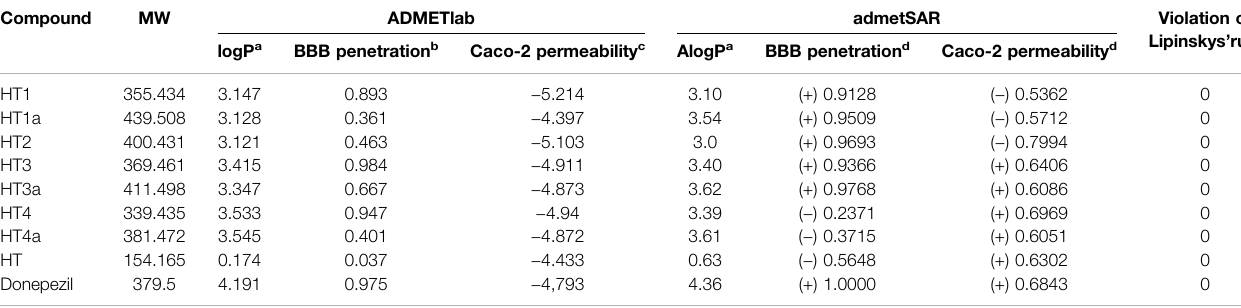
TABLE 4 | Pharmacokinetic properties as predicted in silico by software ADMETlab 2.0 and admetSAR 2.0 Compound MW ADMETlab